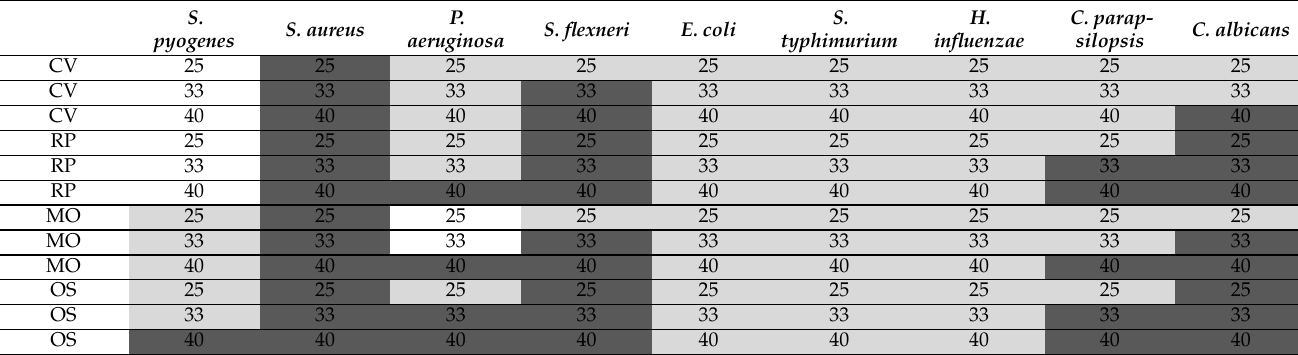
Table 4. The MIC ( µ L/100 mL) for plant extracts CV, RP, MO, and OS.